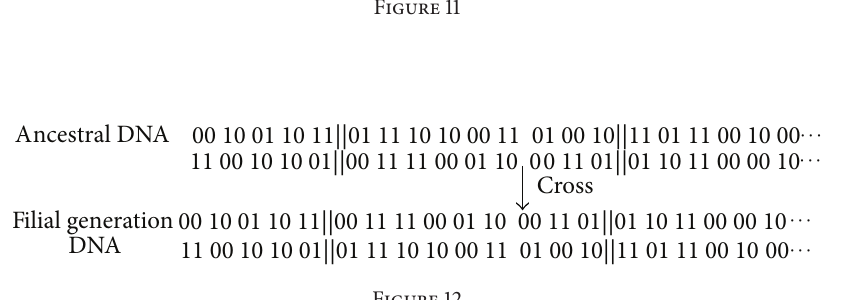
Ancestral DNA TAGGC||CAAGT CTGA||CAGATC Mutate Filial generationDNA TAGGC|| CAAGC CTGA||CAGATC